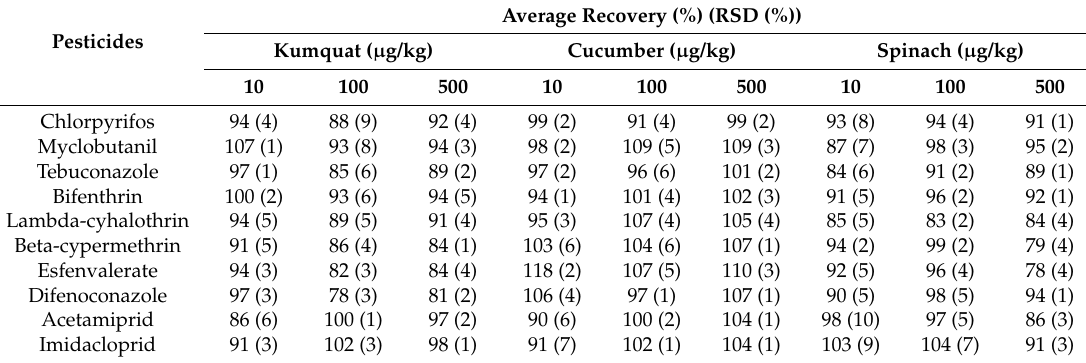
Table 5. Average recoveries and relative standard deviations (RSDs) at three spiked levels in kumquat, cucumber, and spinach ( n = 5).